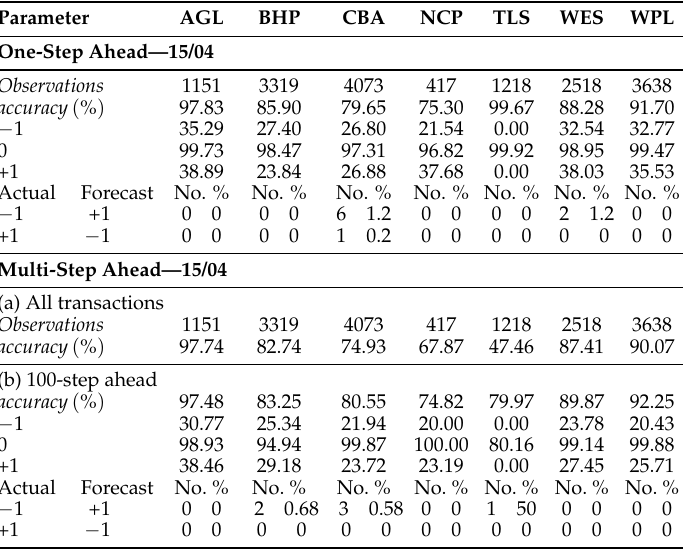
Figure 8. Out of-sample estimated probabilities of direction of price change for 100 observations of CBA, based on actual regressor values. Table 9. Out-of sample forecasts of direction of price change for the last day of the sample, 15 April 2014. First panel contains one-step ahead forecasts based on actual explanatory variables and the second panel, muti-step ahead with predicted